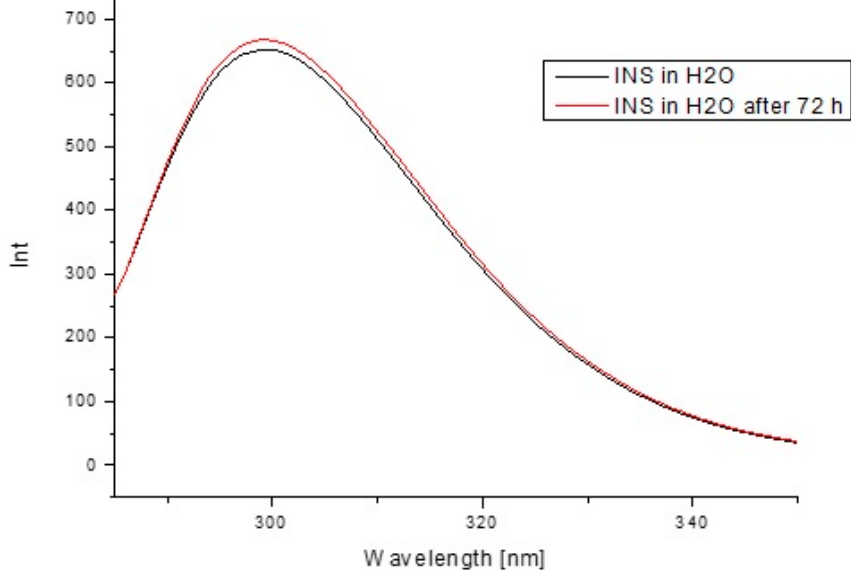
Figure 13. Emission fluorescence spectra of insulin at 1.04 × 10 − 5 g/cm 3 concentration in H 2 O immediately after sample preparation and after 72 h.